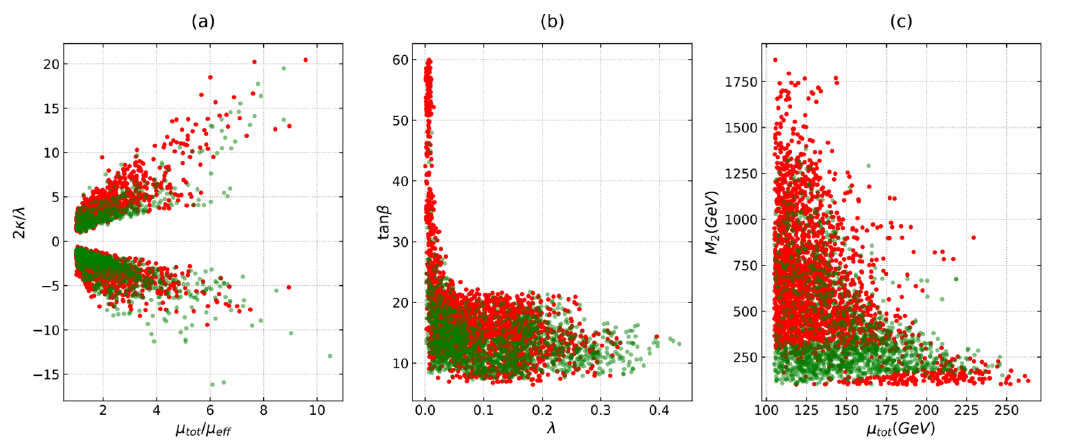
Figure 4 . The projection of samples on the λ – κ plane, λ – tan β plane and µ tot – M 2 plane. Samples represented by green points indicate ones excluded by DM direct detection limits and those represented by red points are surviving samples confronted with these